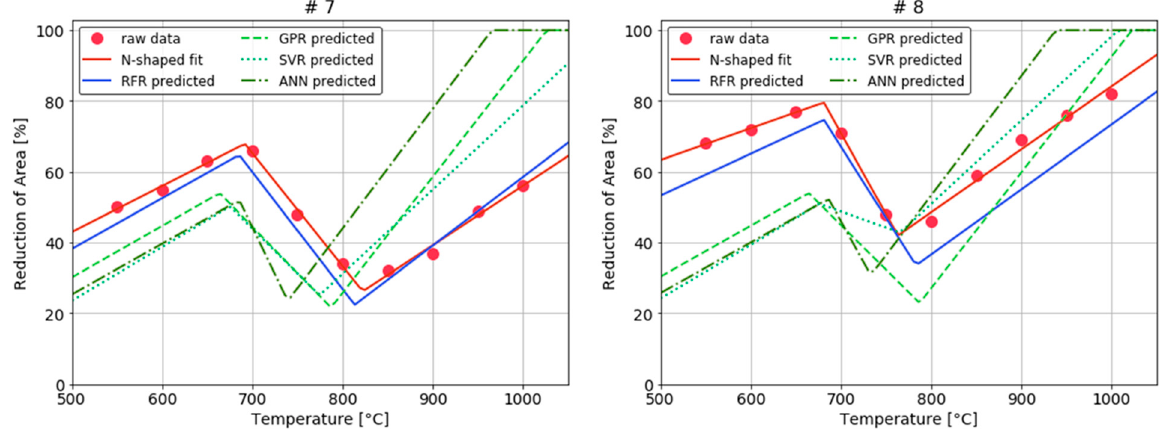
Figure 7. Comparison with performance of four prediction models for N -shaped fitting model of steel grade #7 and #8.